Question: What does this figure show? Answer in one sentence.
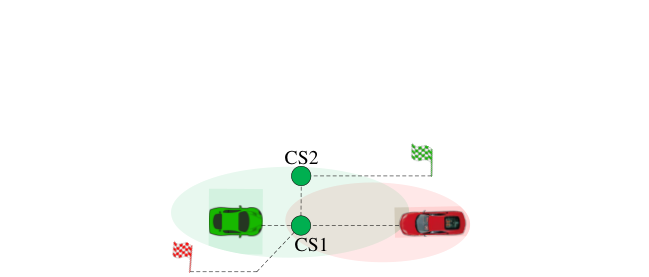
Answer: The origin, destination, and driving range of two EVs, along with the locations of CSs are shown. If the green EV charges at CS1, then the travel time of the red EV gets extended, as the red EV has to wait until CS1 becomes available. If the green EV charges at CS2 instead of CS1, that results into a shorter travel time for the red EV. Both paths have the same travel time for the green EV. even along the same highway. In essence, our novel problem is to ensure the optimality of each EV’s charging route individually, while refrain from using the CSs which can be better utilized by other EVs, hence, improving the travel time of all EVs. We denote this problem as Proactive EV Route Planning (PERP) problem. Devising an efficient and scalable solution of the problem is challenging for the following reasons: (i) Hardness of the problem: Even finding a route with the minimum travel time for each EV with one or multiple recharging, which also requires finding the optimal amount of time